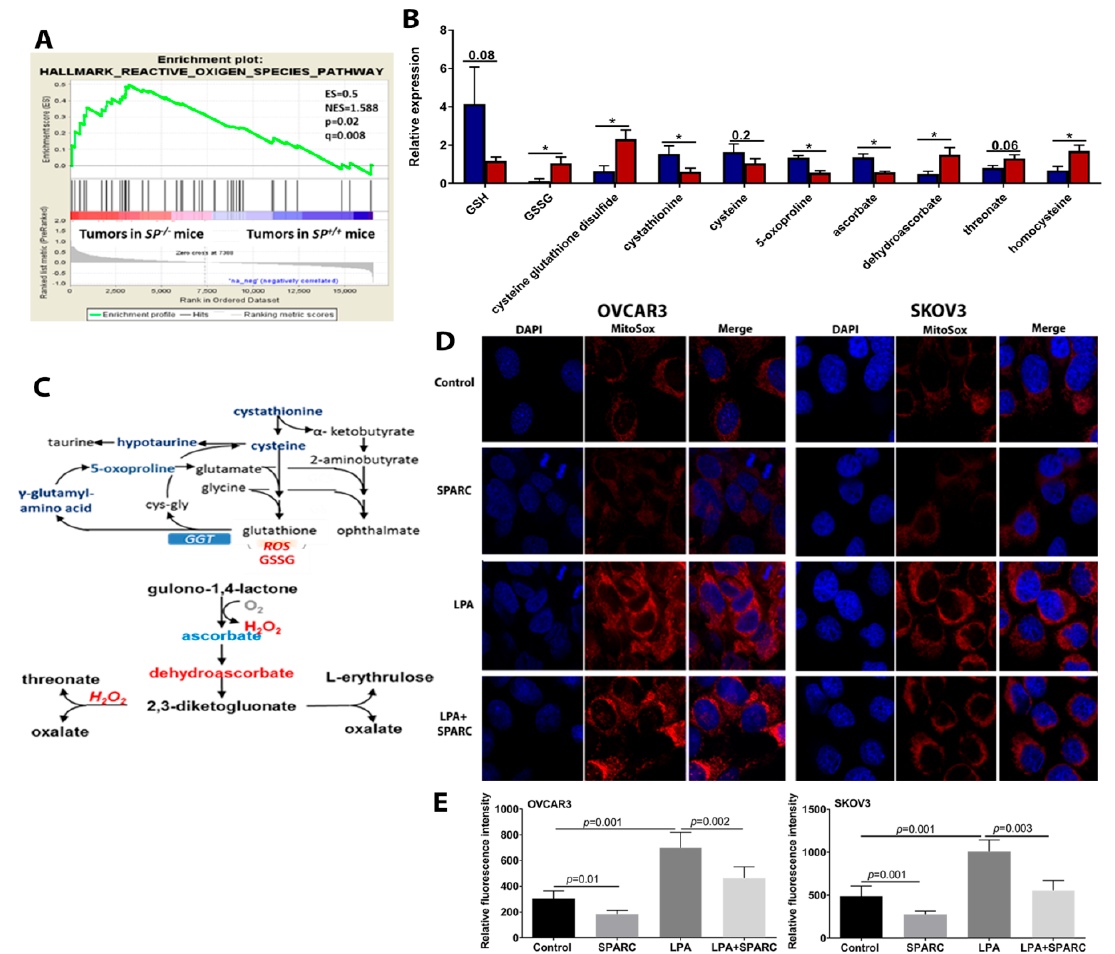
Figure 8. Effect of SPARC on mitochondrial ROS in OvCa cells. ( A ) GSEA graph depicting enrichment of ROS in syngeneic tumors from SP − / − mice. ( B ) Bars depict the relative expression of the indicated metabolites in syngeneic ID8 tumors in SP +/+ and SP − / − mice. * p < 0.05 unpaired Student’s t -test. ( C ) Schema of the pathway of the metabolites involved in redox signaling. Red: upregulated; Blue: downregulated. ( D ) MitoSox fluorescence microscopy of SKOV3 and OVCAR3 treated with LPA with and without SPARC. ( E ) Bars depict mean ± SEM of the fluorescent intensity of images in ( D ) p < 0.05, Mann-Whitney’s test.